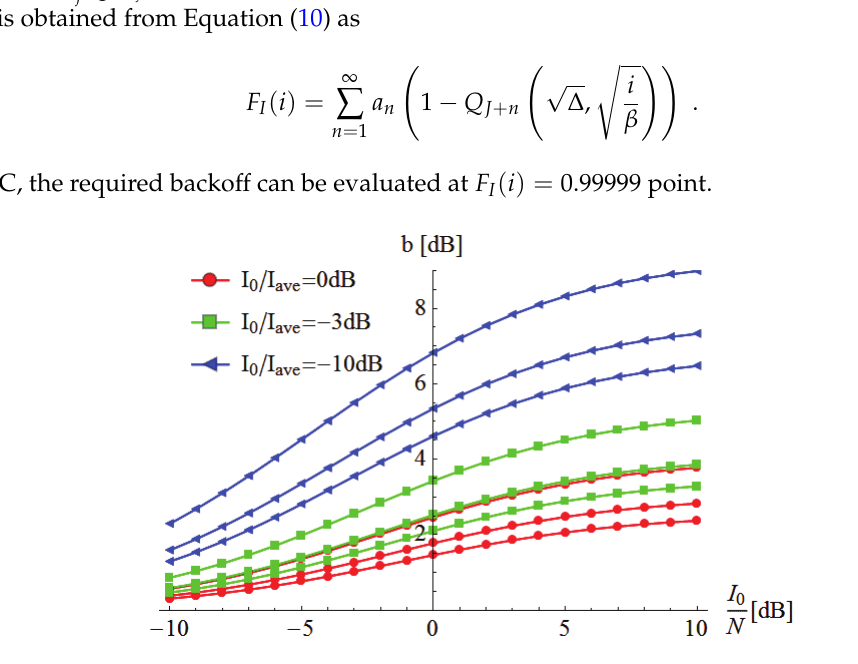
Figure 5. Required backoff for three different I 0 / I ave . Three curves per I 0 / I ave represents J = 1,2,3. The backoff for J = 1 is always largest and for J = 3 smallest for a given I 0 / I ave